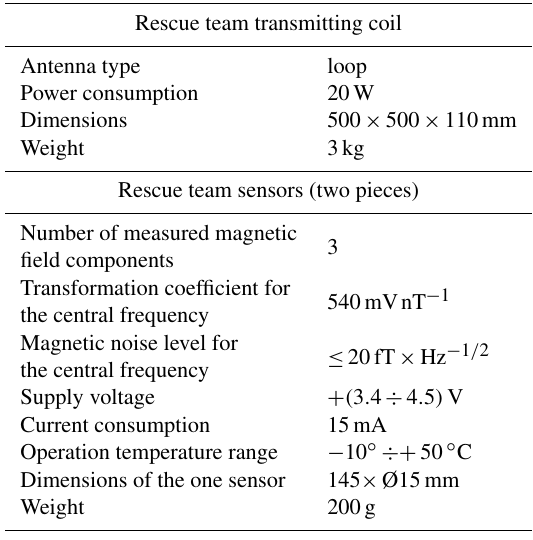
Table 2. Main parameters of rescue team instrumentation